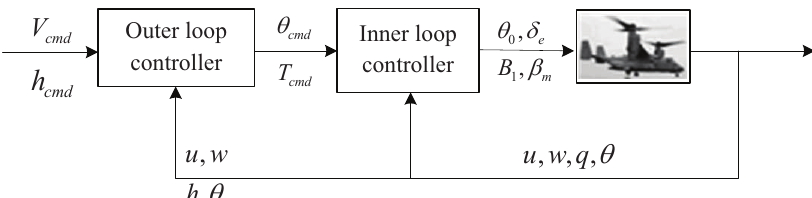
Figure 6. Control block diagram in conversion flight mode.